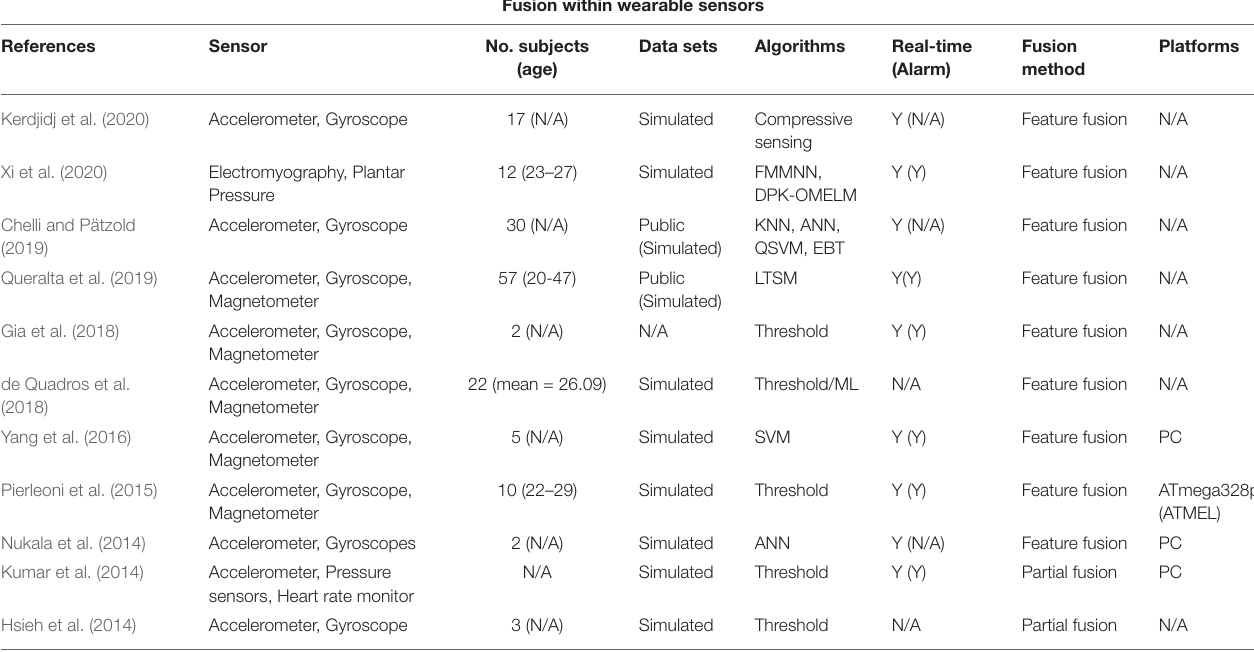
TABLE 6 | Fall detection by fusion of wearable sensors from 2014 to